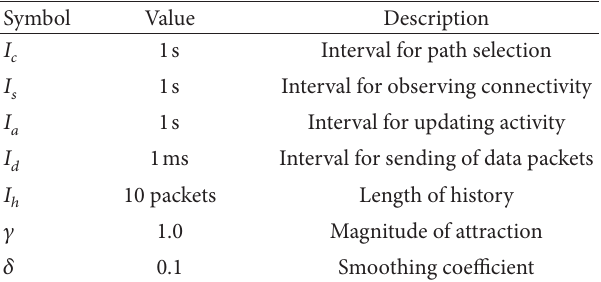
Table 4: Parameter setting.